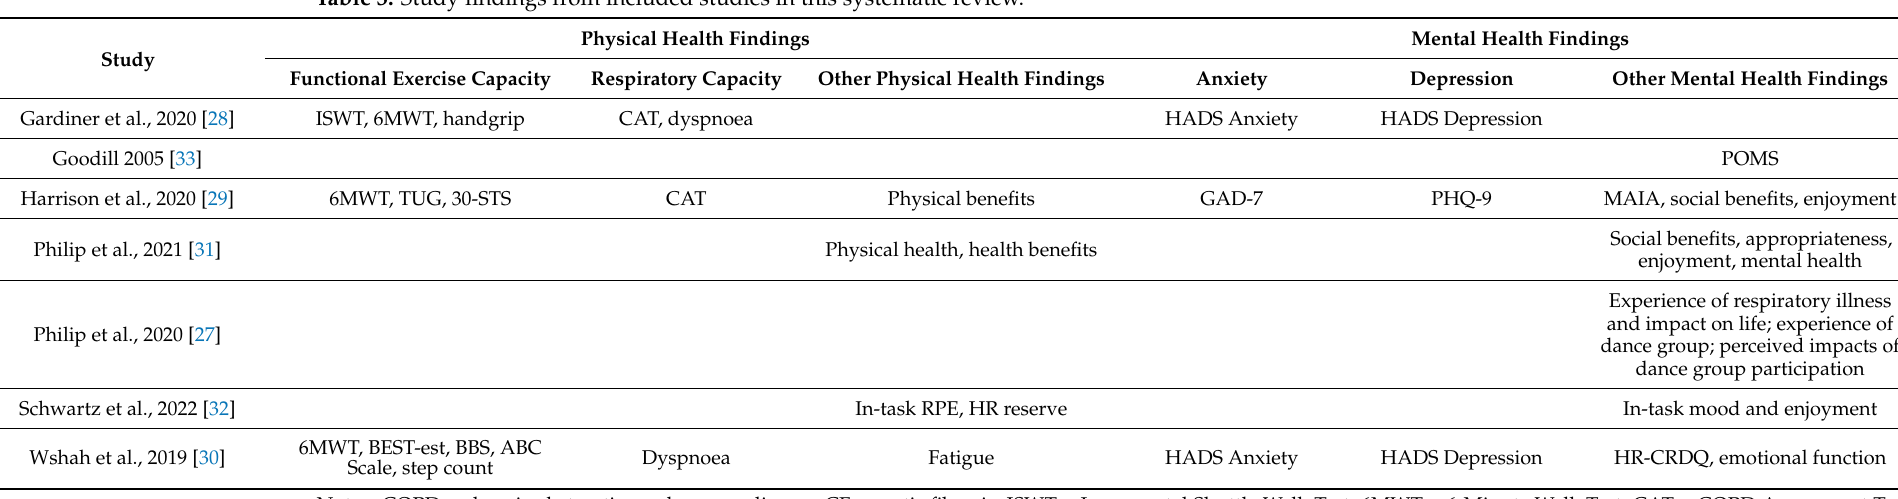
Table 3. Study findings from included studies in this systematic